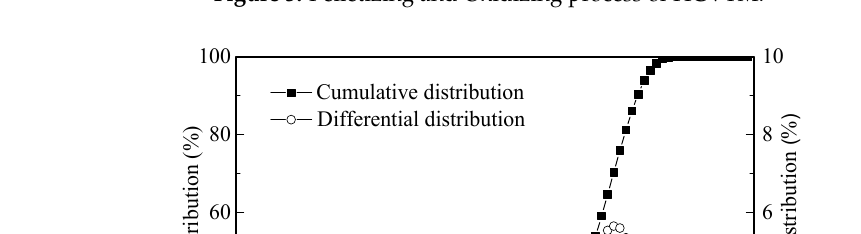
Figure 3. Pelletizing and Oxidizing process of HCVTM.